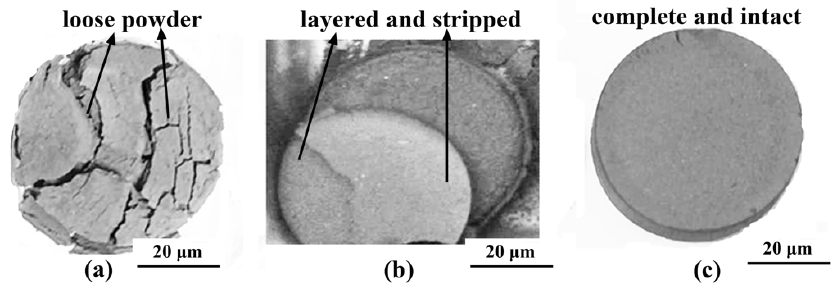
Figure 3. Formability of different molding agents: ( a ) paraffin; ( b ) PEG-2000; ( c ) PVA-1788.